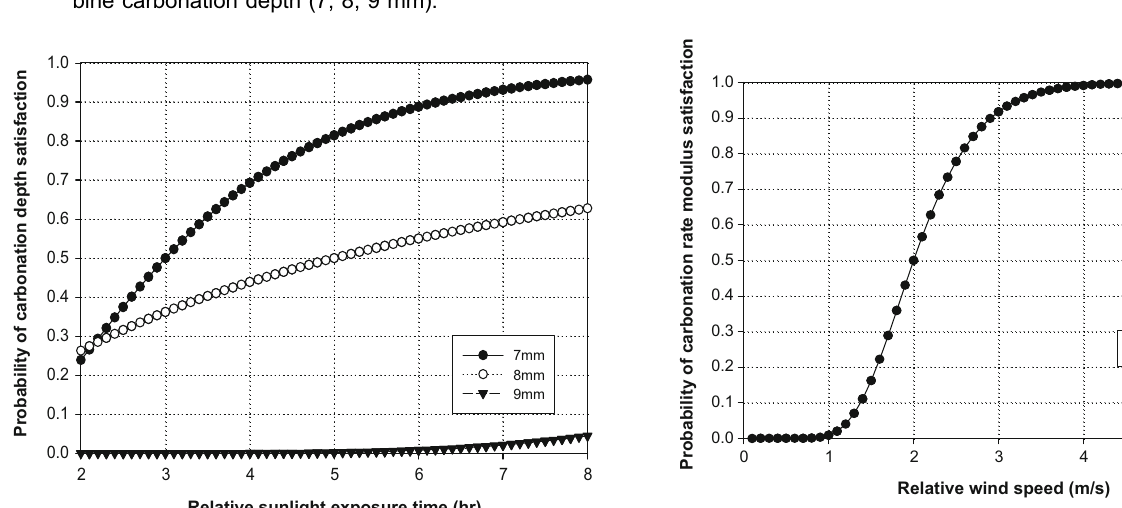
Fig. 6 Satisfaction curve of wind speed parameter for com- bine carbonation depth (7, 8, 9 mm).